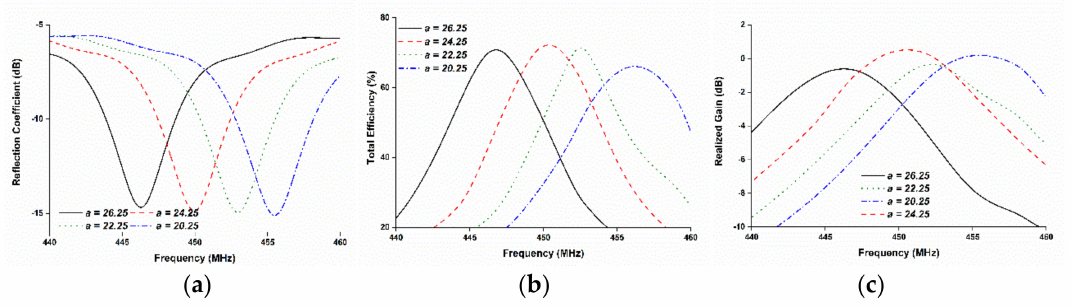
Figure 2. Parametric study on slot length a ; ( a ) reflection coefficient, ( b ) total efficiency and, ( c ) realized gain: decreasing the slot length causes the resonant frequency to shift